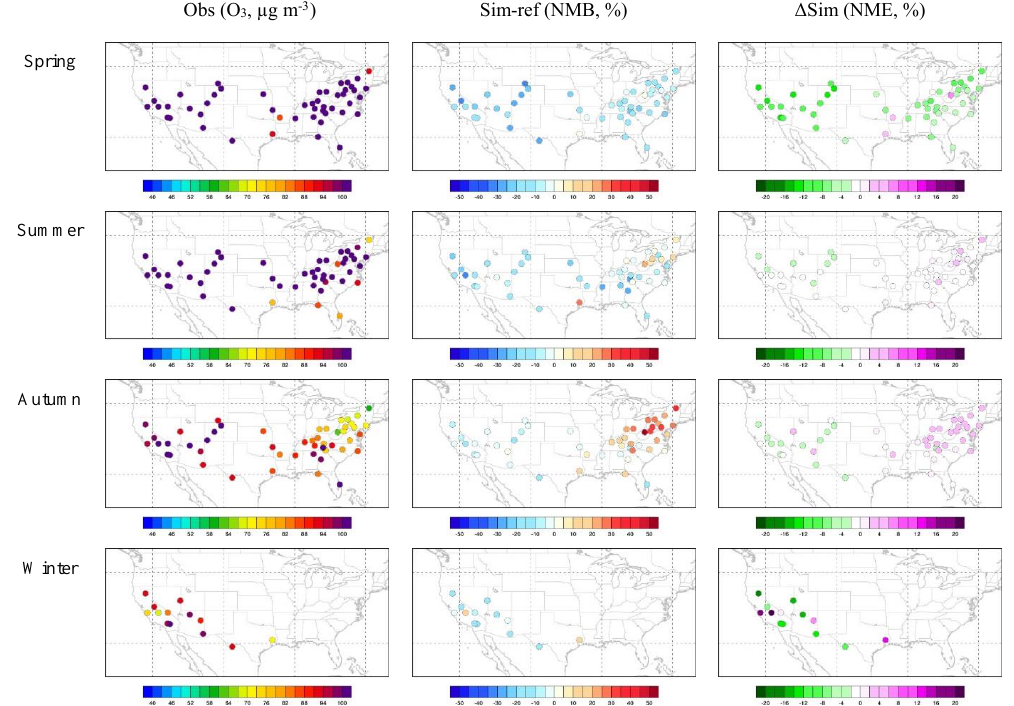
Figure 8. Comparison with CASTNET surface daily maximum 8h average O 3 concentrations ( (cid:49) Sim = Sim-new minus Sim-ref in